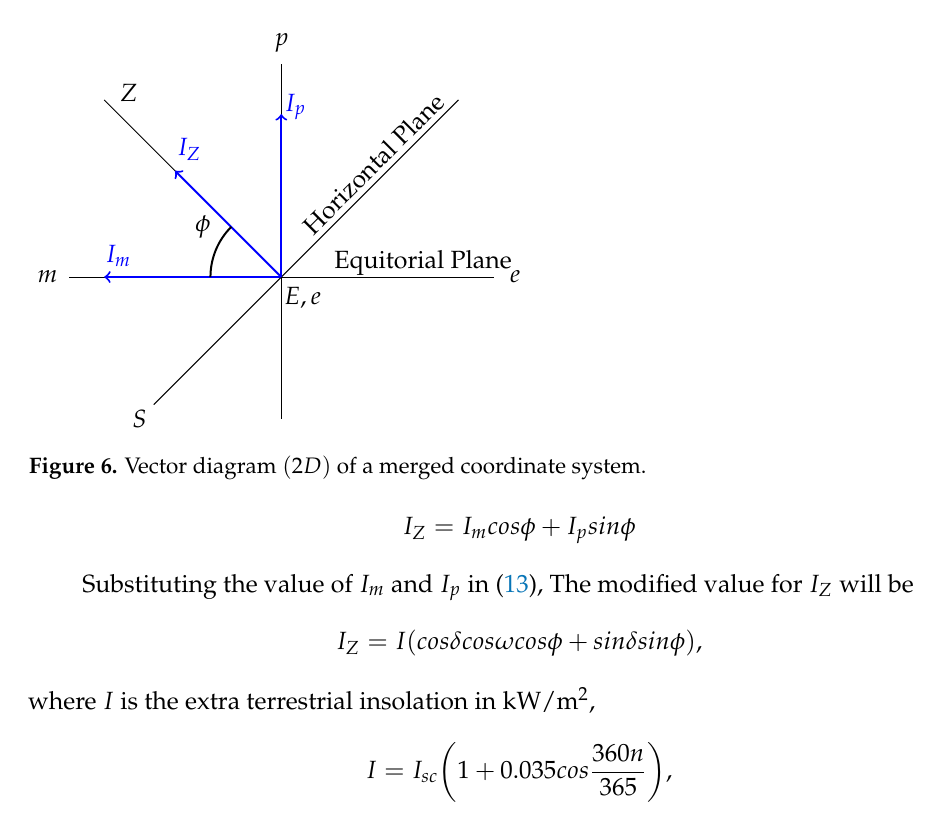
where I is the extra terrestrial insolation in kW/m 2 ,